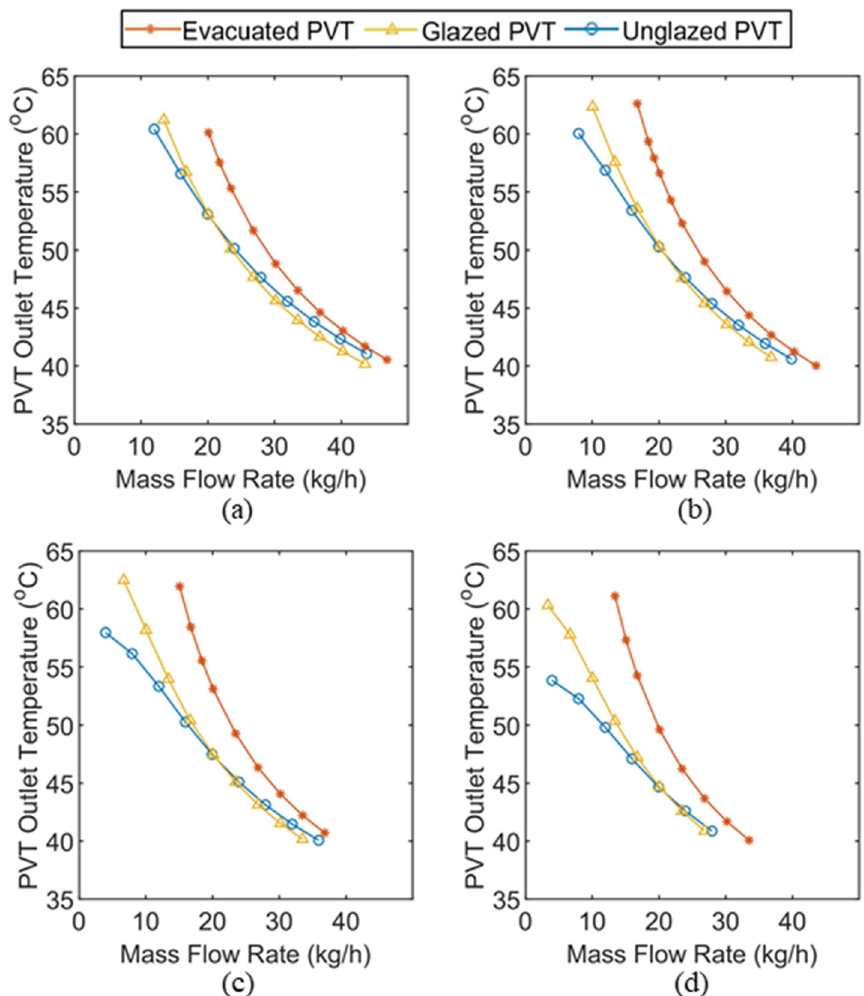
Figure 4. Hot water production with different PVT systems at irradiance of: ( a ) 1000 W/m 2 ; ( b ) 900 W/m 2 ; ( c ) 800 W/m 2 ; ( d ) 700 W/m 2 .